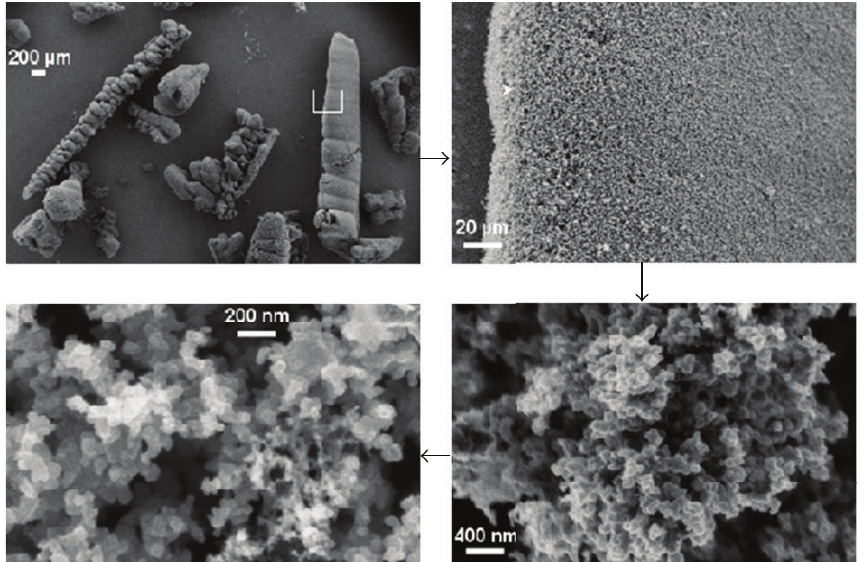
Figure 6: SEM observation of the porous-like structure.